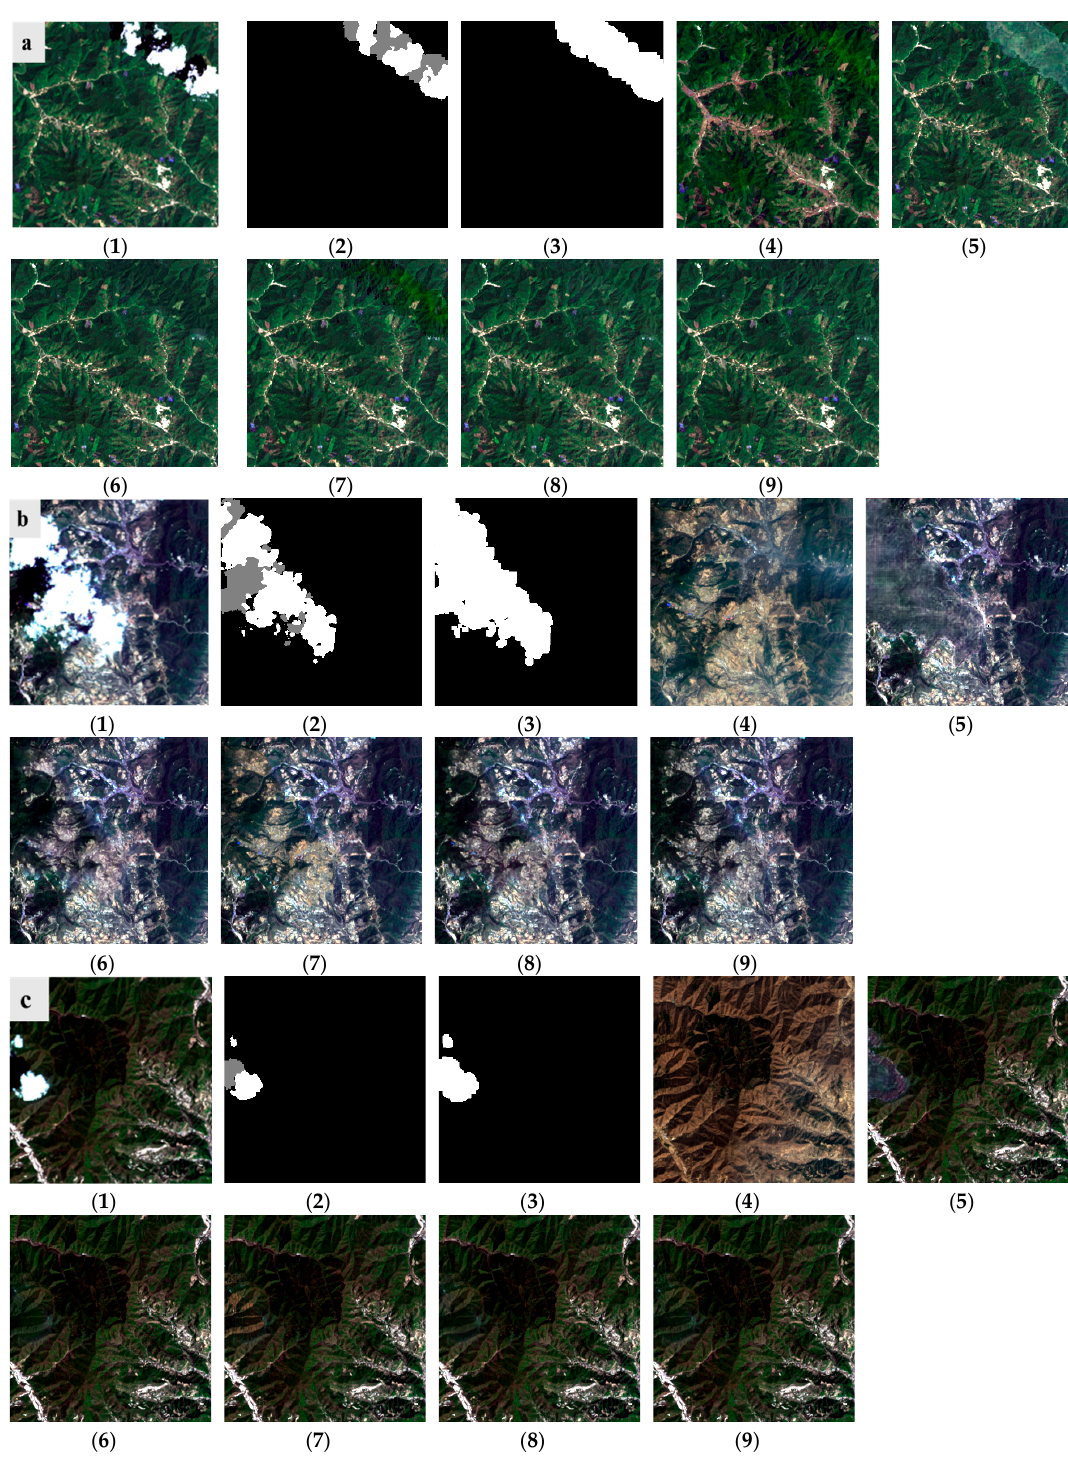
Figure 6. Comparison of cloud removal results predicted from different methods. ( 1 ) Real cloudy image. ( 2 ) Clouds and cloud shadows mask detected from CDN with high recall. Cloud shadows are marked by gray, and clouds are marked by white. ( 3 ) Mask after expansion operation. All invalid pixels are marked by white. ( 4 ) Temporal image. ( 5 ) Pconv. ( 6 ) STSCNN. (7) NL-LRTC. ( 8 ) CRN. ( 9 ) STGCN. ( a – c ) are repaired samples of real cloud images from di ff erent